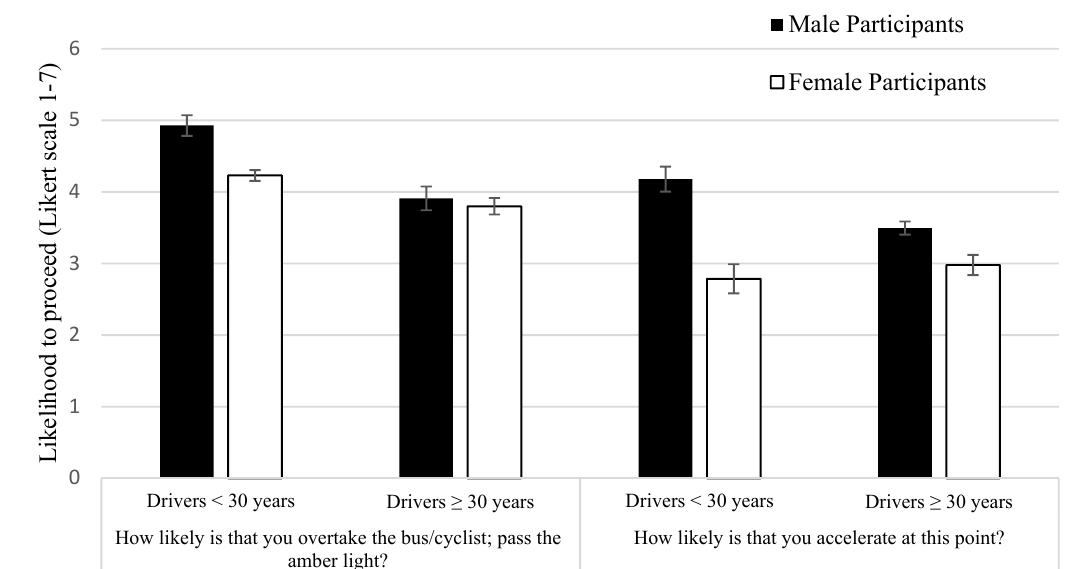
Figure 2. Mean ratings breakdown for gender and age across the two questions: “How likely is that you overtake the bus/cyclist; pass the amber light?” and “How likely is that you accelerate at this point?” (with standard error bars).